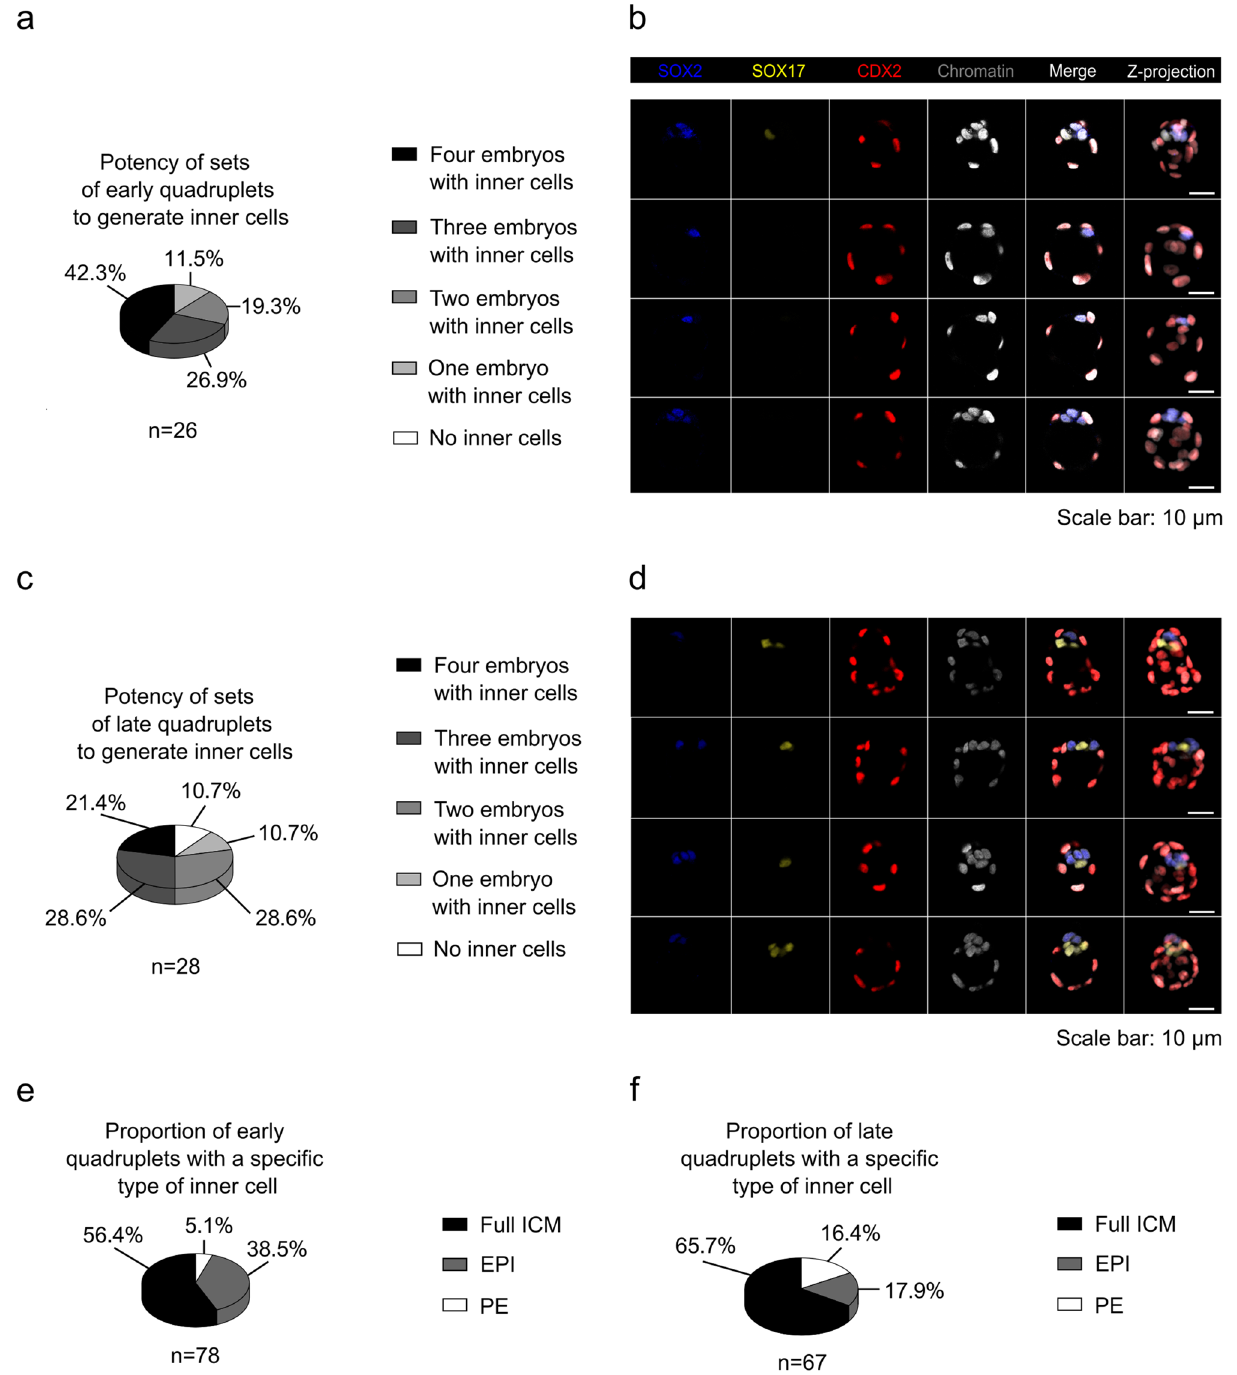
Figure 6. Potency of sets of early and late quadruplet blastocysts to generate inner cells. ( a ) Developmental potential of sets of early quadruplets to generate inner cells. ( b ) Representative immunofluorescence confocal images of a set of early quadruplet blastocysts showing the localization of cells expressing SOX2 (blue), SOX17 (yellow), and CDX2 (red). Chromatin (white) was labeled with chromomycin A 3 . The last panel corresponds to the average intensity projections of Z-stack images. Scale bar: 10 µm. A set in which one embryo had an ICM consisting of EPI and PE progenitors and the remaining three created only EPI progenitors is presented. ( c ) Developmental potential of sets of late quadruplets to generate inner cells. ( d ) Immunostaining for SOX2 (blue), SOX17 (yellow), and CDX2 (red) protein in a representative set of late quadruplet blastocysts. Chromatin (white) was labeled with chromomycin A 3 . The last panel corresponds to the average intensity projections of Z-stack images. Scale bar: 10 µm. A set in which four embryos had an ICM consisting of EPI and PE cells is shown. ( e ) Percentage of early quadruplets with a specific type of inner cell. n indicates the number of all quadruplet blastocysts (not sets). ( f ) Percentage of late quadruplets with a specific type of inner cell. n indicates the number of all quadruplet blastocysts (not